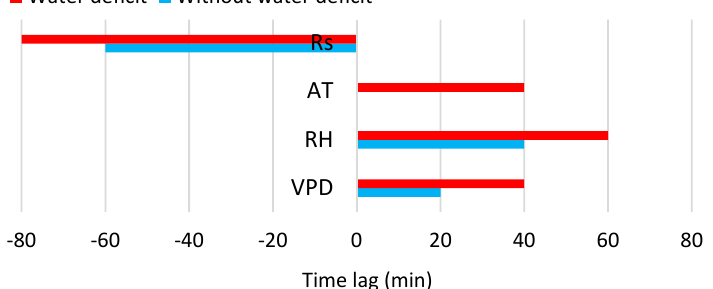
Figure 9. Changes in time lags for conditions with water deficit (REW < 0.4) and without water deficit (REW > 0.4).